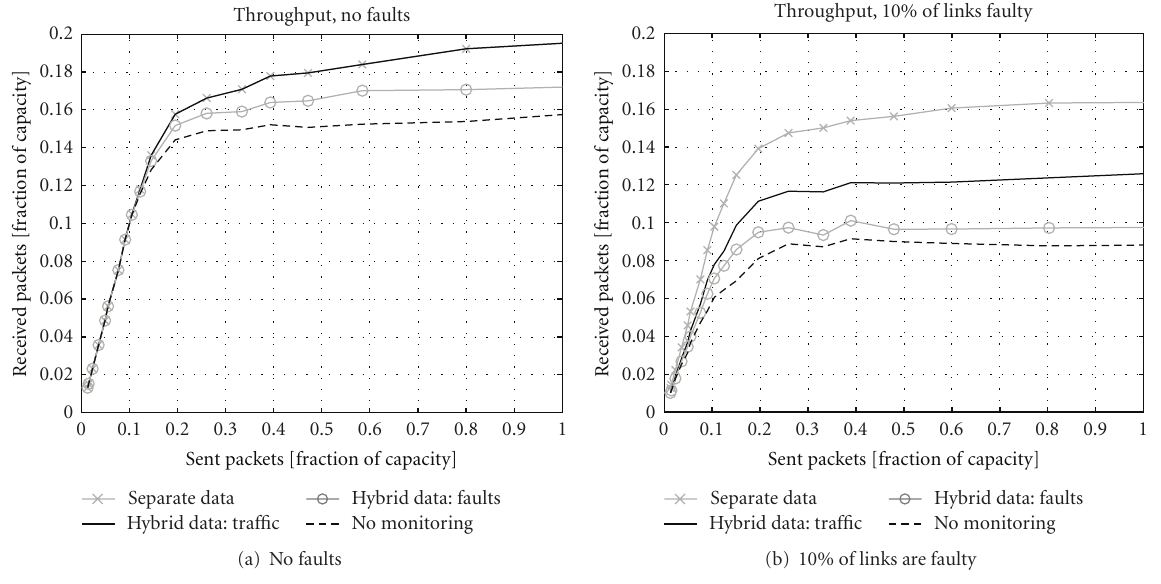
Figure 12: Throughput with separate tra ffi c and fault data as well as with the hybrid formats. C Size = 5 and data processing is enabled.